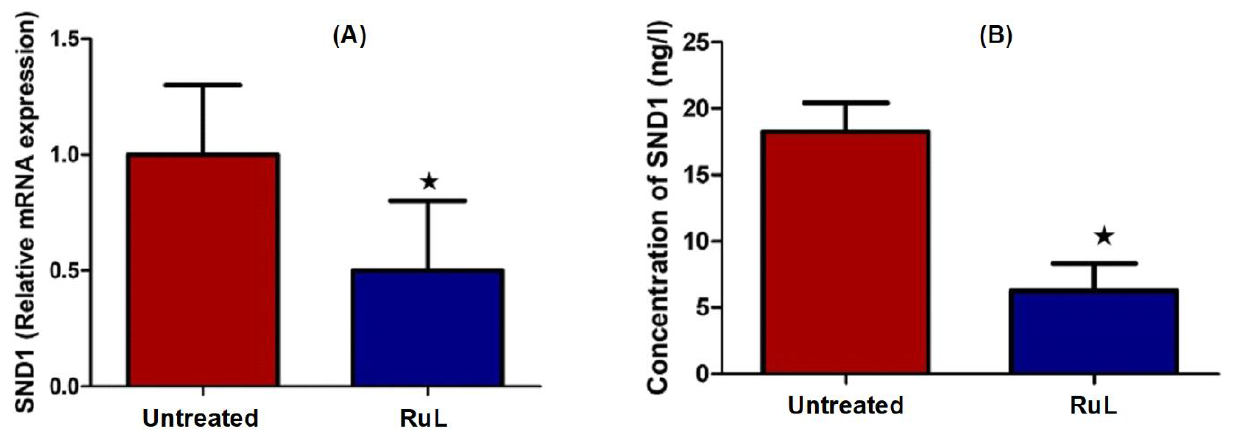
Figure 10. Effect of the RuL complex on SND1 of HepG2 cells: ( A ) gene expression; ( B ) protein level. Results are expressed as mean ± SD of two independent experiments performed in triplicate. Statistical differences were analyzed with a t -test. * Significant at p < 0.05.